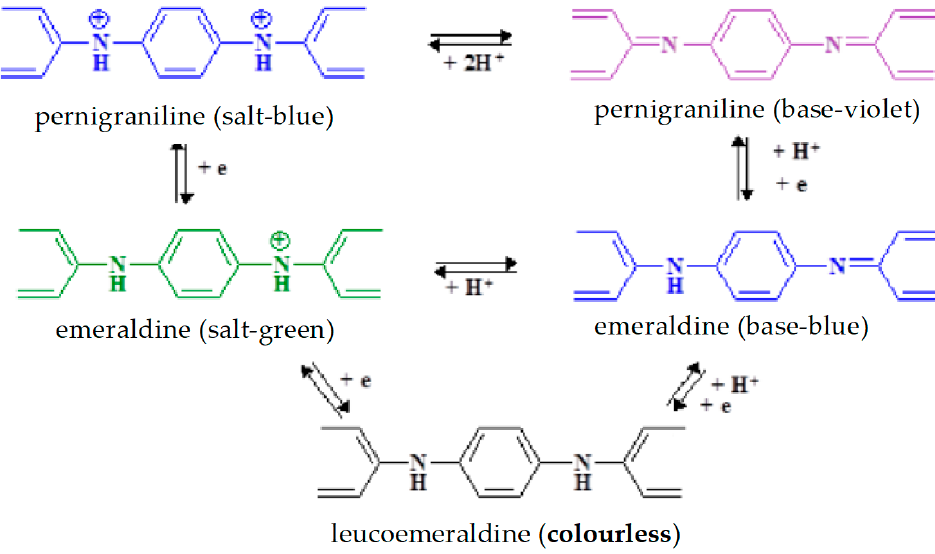
Figure 3. Different forms of polyaniline depending on acid – base conditions and oxidation states.